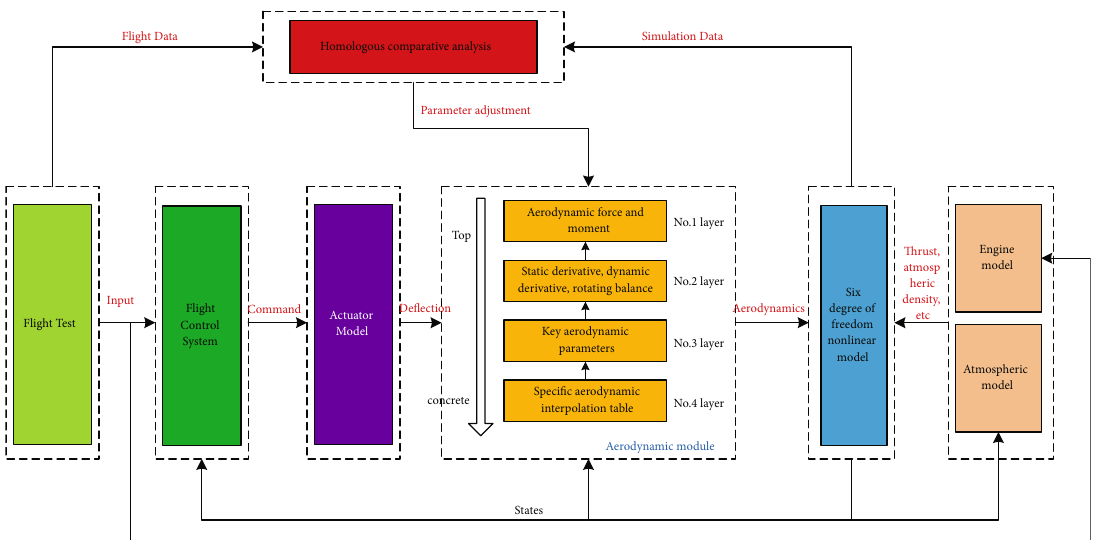
Figure 5: Flowchart of the homologous comparative analysis.